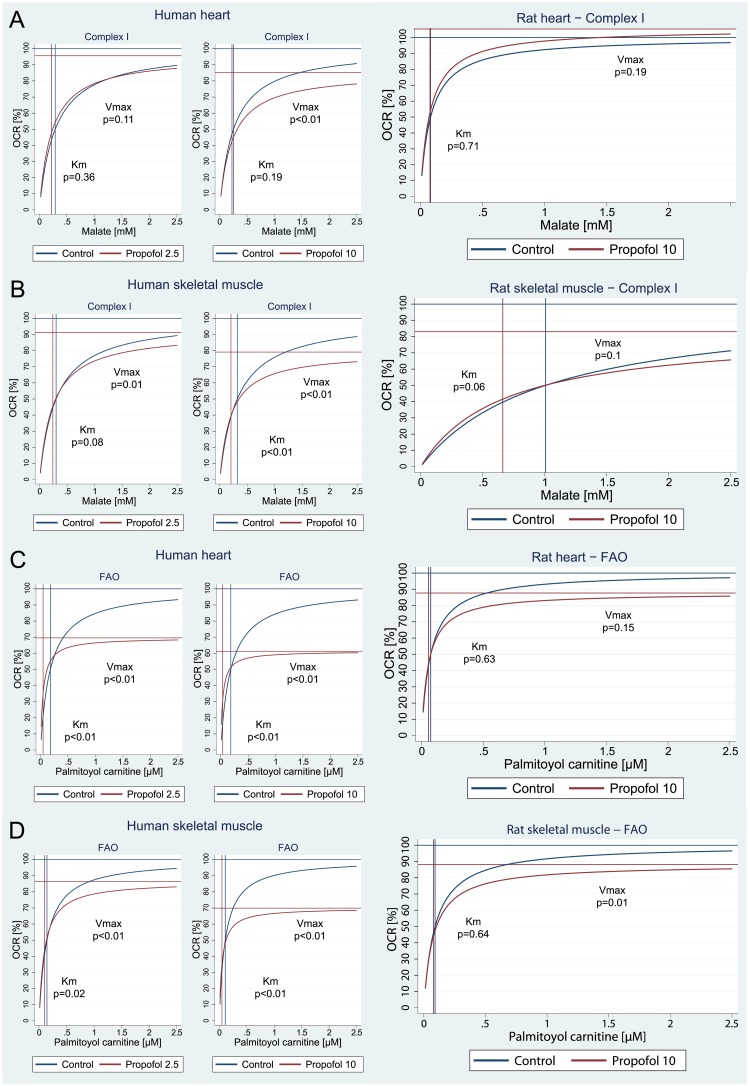
Kinetics of inhibition by 2.5 μg/ml and 10 μg/ml of propofol in human muscle homogenates (left and middle figures), and by 10 μg/ml in rat muscle homogenates (right figure).A = Complex I in heart tissue. B = Complex I in skeletal muscle. C = FAO in heart tissue. D = FAO in skeletal muscle. Based on multi-level linear regression model of independent measurements in all subjects. Note: FAO = fatty acid oxidation, OCR = oxygen consumption rate.